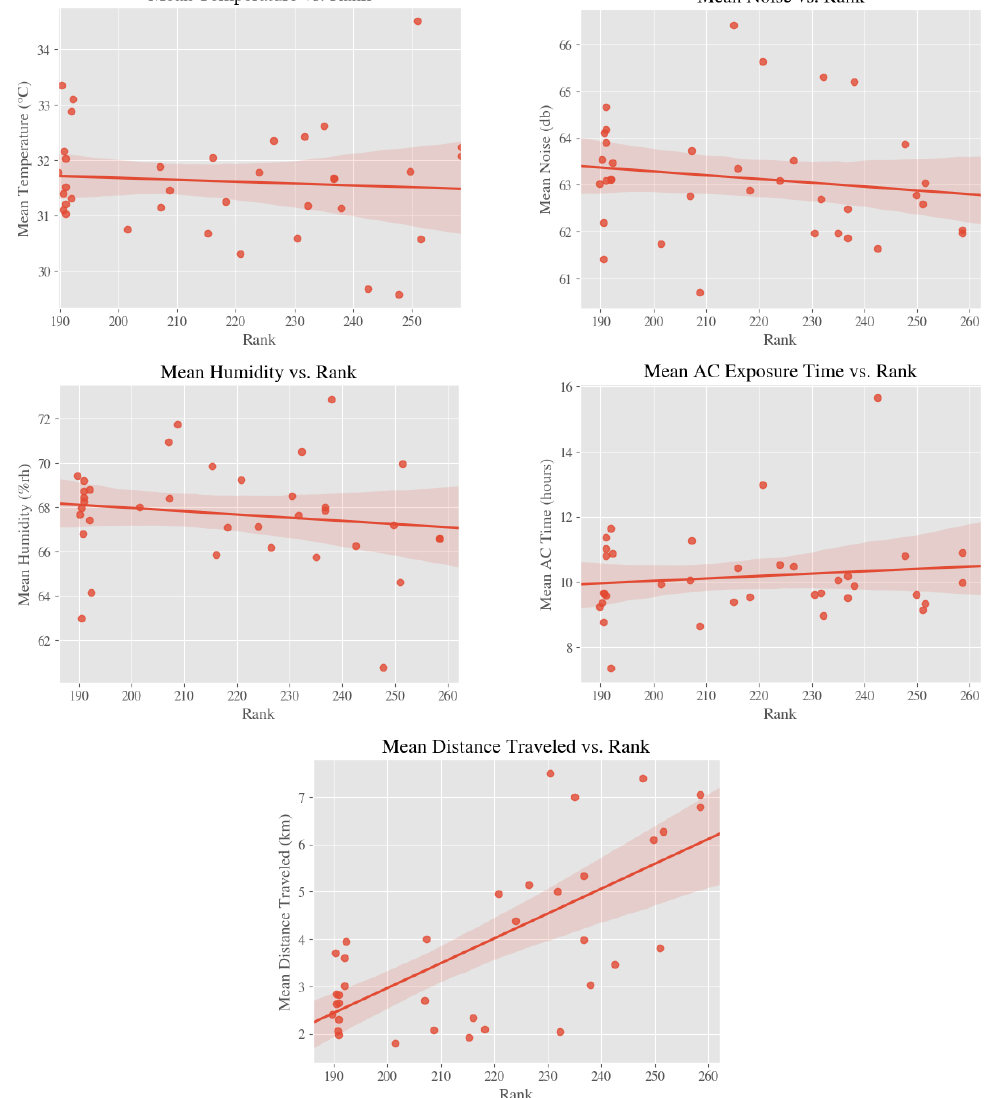
Figure 4. Relationships between environmental exposures/distance and school academic